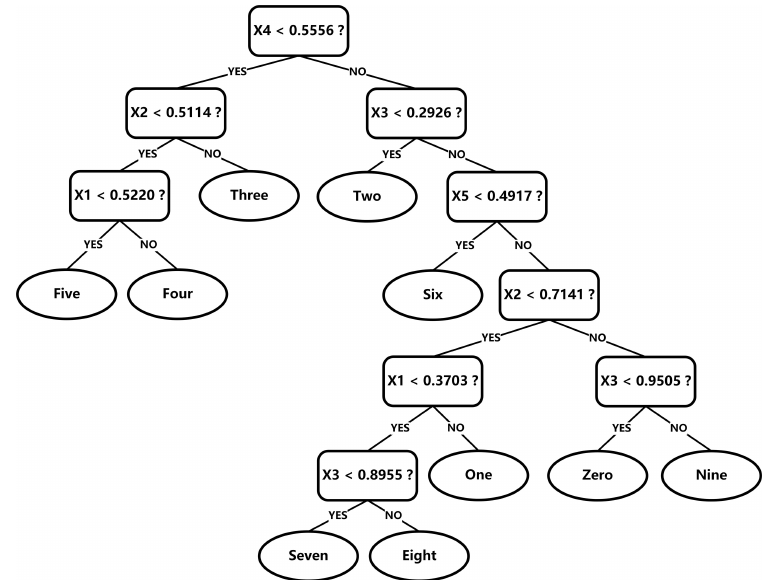
Figure 5. The binary decision tree model used for the gestures classification task, where X1–5 represents the normalized resistance change rate at the thumb, index finger, middle finger, ring finger and little finger, respectively.